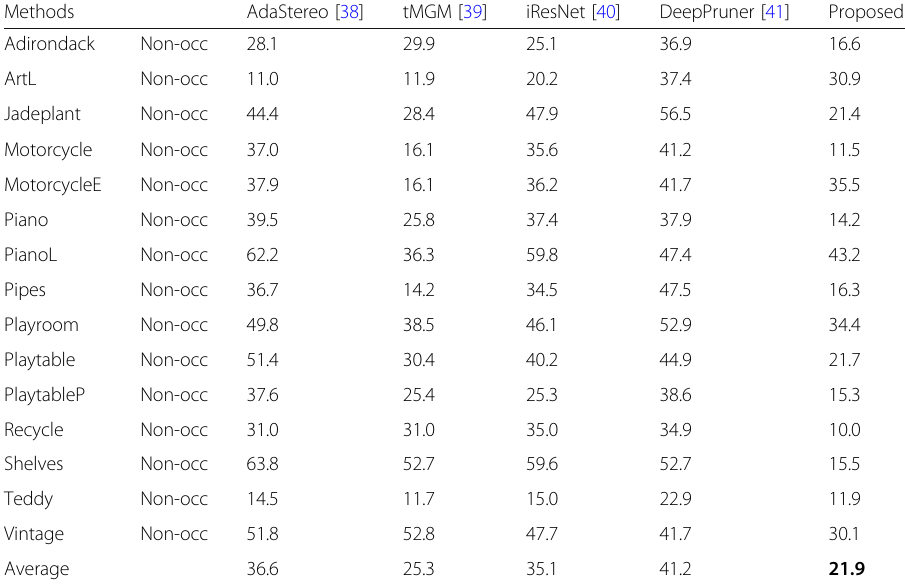
Table 4 Error rate (%) of the proposed and other stereo matching algorithms